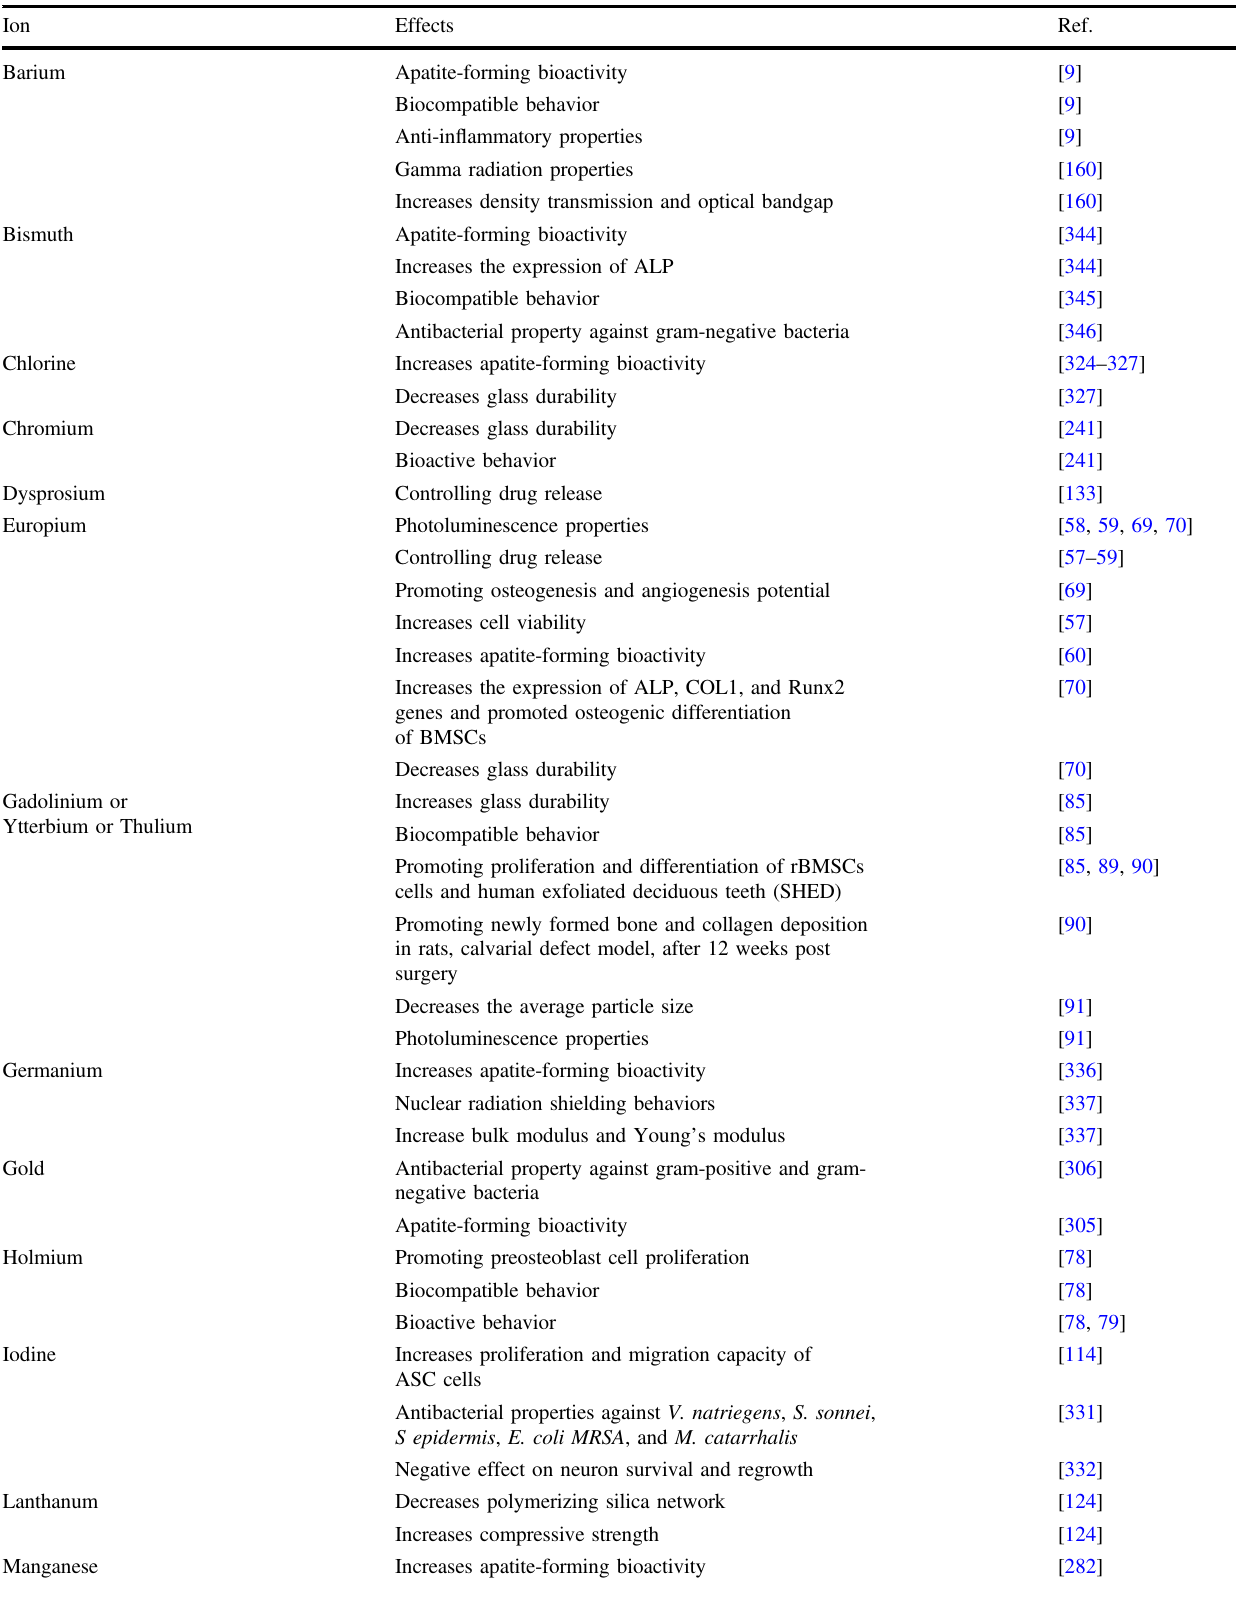
Table 3 Effects “ less-common ” ions incorporated in bioactive